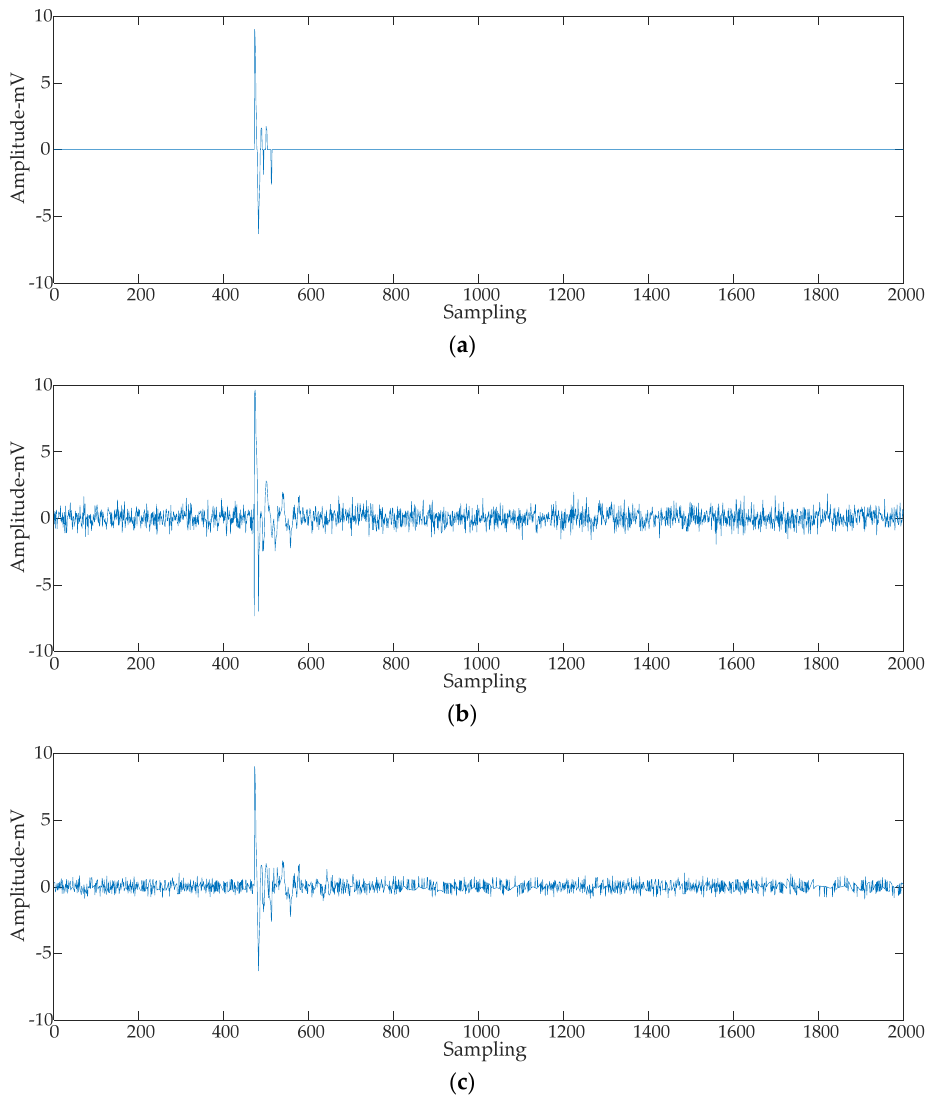
Figure 18. Denoising results of partial discharge signal measured in the laboratory. ( a ) Denoising results of the proposed